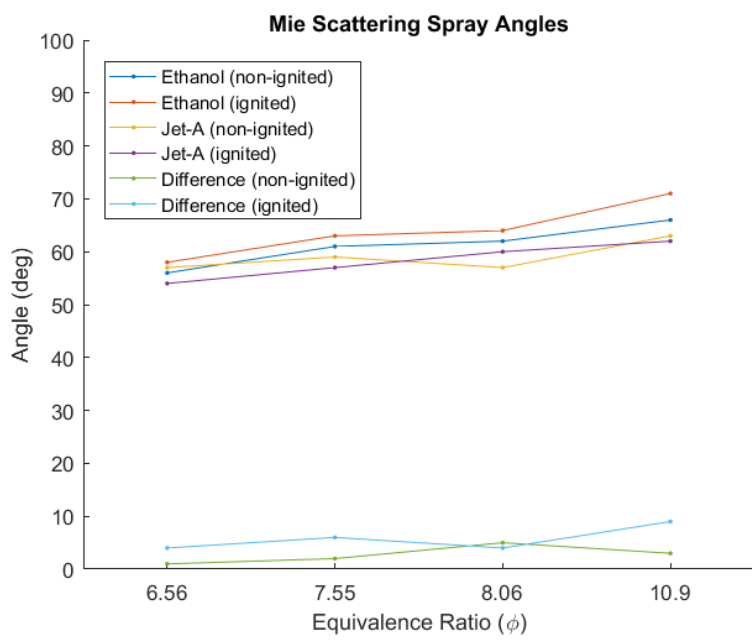
Figure 9. Spray angles obtained from processing of Mie scattering images. Difference lines represent subtractions of Jet A angles from ethanol angles for non-ignited and ignited conditions, respectively.